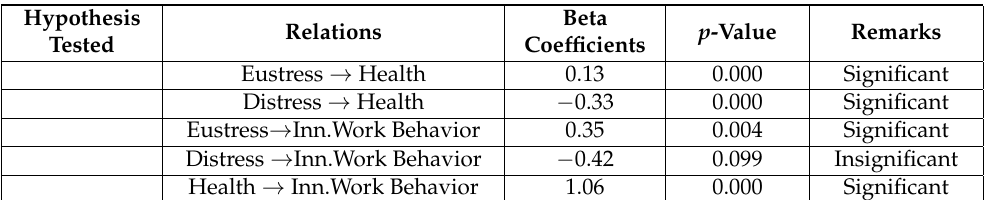
Table 7. Hypotheses testing.